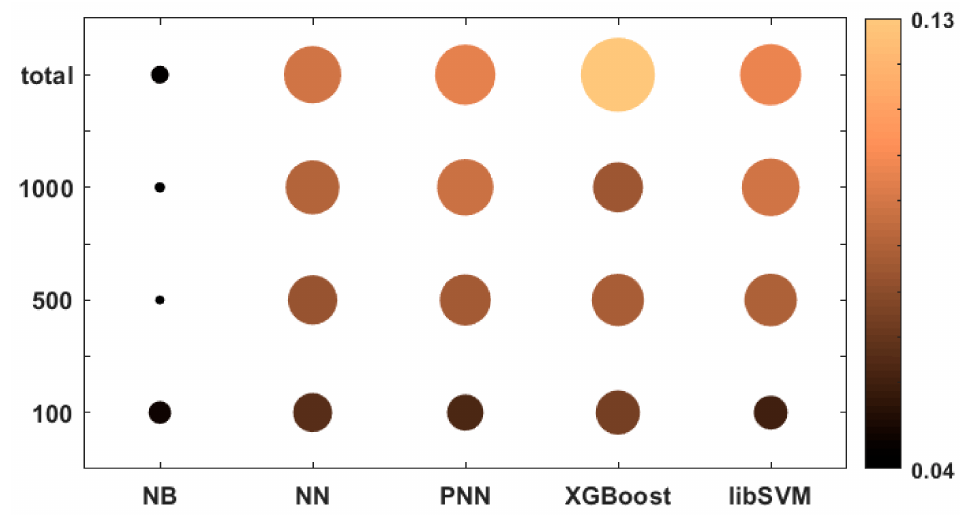
Figure 6. Bubble plot of the performances of the machine learning algorithms at different dataset sizes for Case Study 2. Both the colors and the radii of the circles correspond to the average of the 25 normalized performance parameter values. (The bigger (and brighter) the